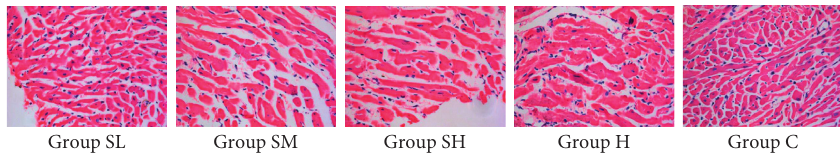
Figure 1: HE staining of atrial tissue.